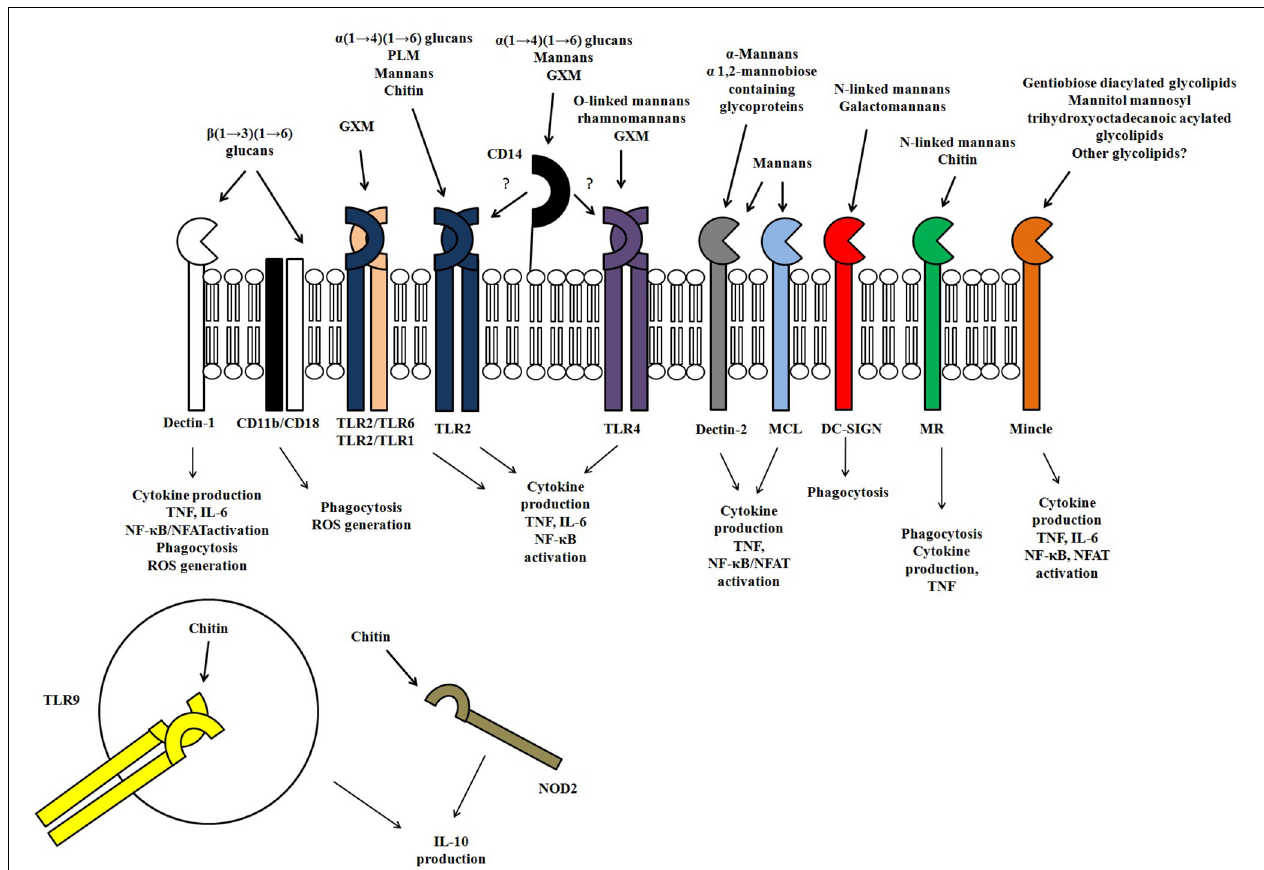
FIGURE 2 | Representation of the receptors involved in the innate immune recognition of fungal polysaccharides and glycoconjugates, as well the responses evoked in response to fungal polysaccharides.